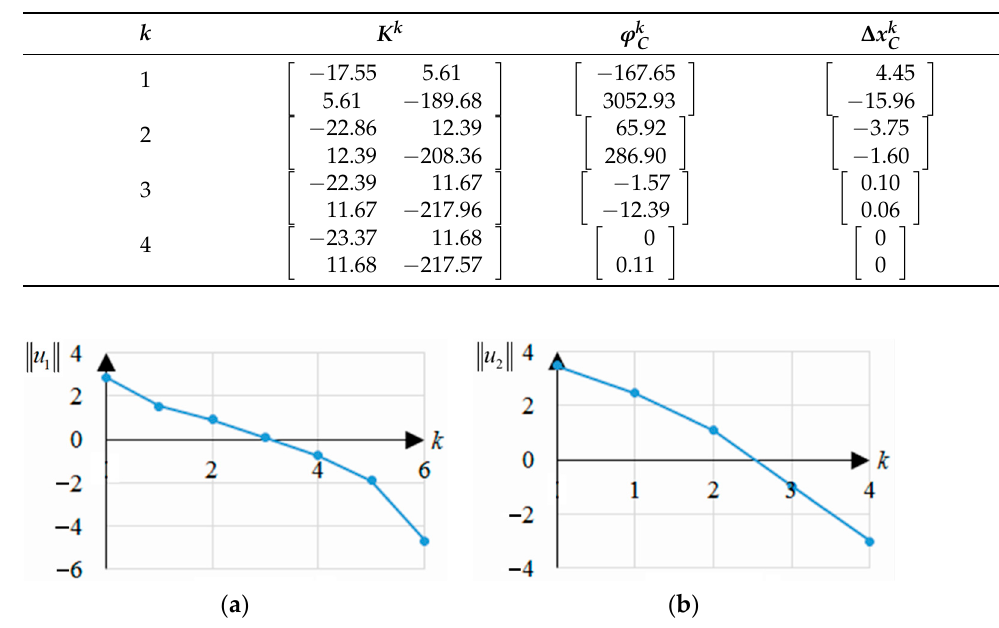
Figure 5. Process of convergence: ( a ) modified node method (MNM); ( b ) modified loop method (MLM).